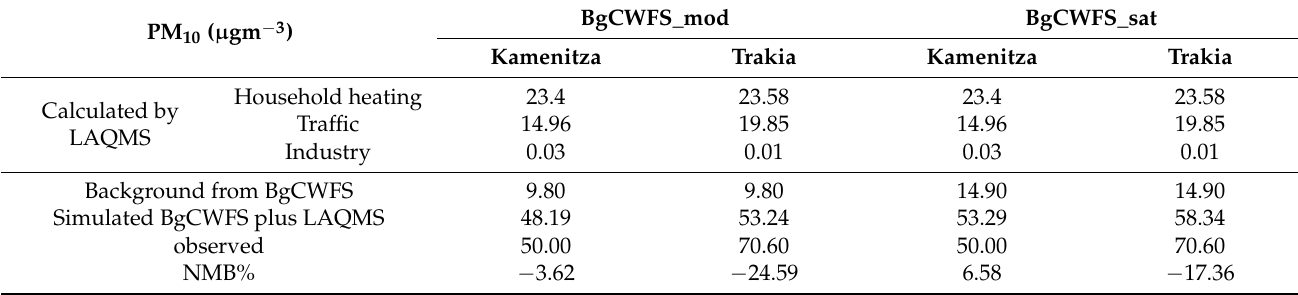
Table 4. Monthly mean PM 10 from LAQMS and (LAQMS + BgCWFS) for February 2019 at AQ stations Kamenitza and